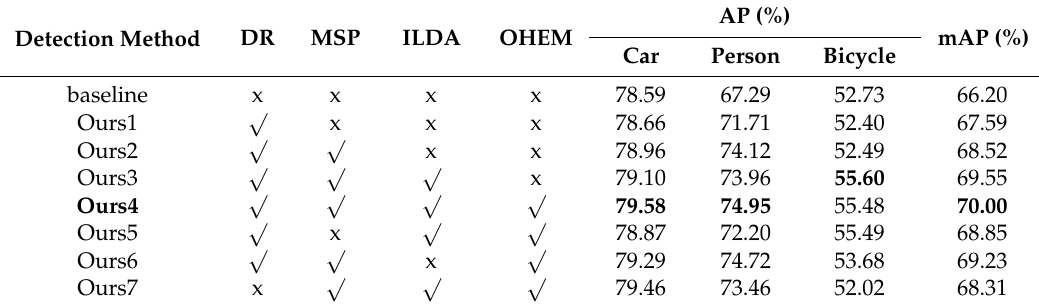
Table 2. The results of comparative experiments of the different parts in our frame. Bold numbers indicate the highest indicator values of all frames. IOU threshold is 0.3.